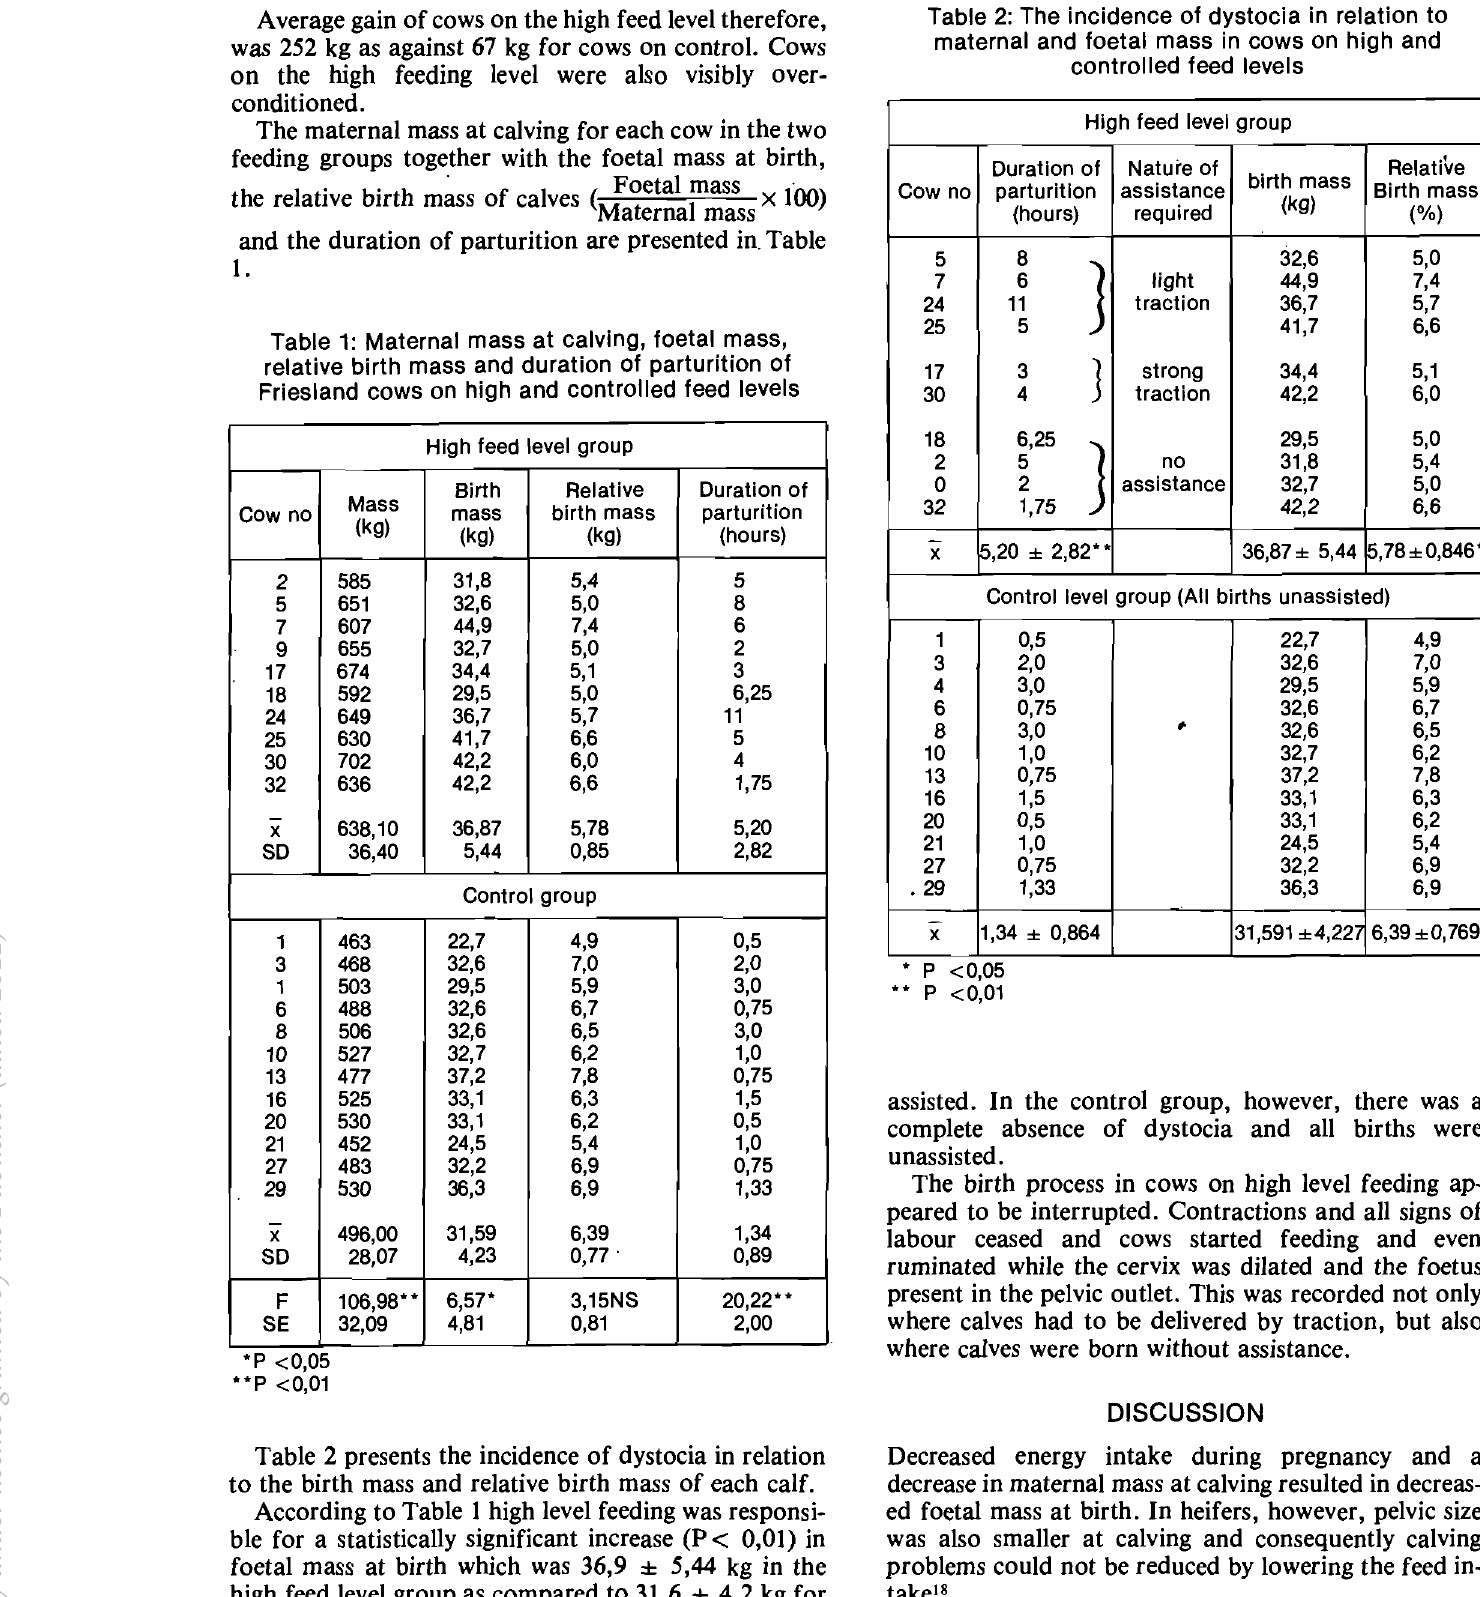
Table 1: Maternal mass at calving, foetal mass,